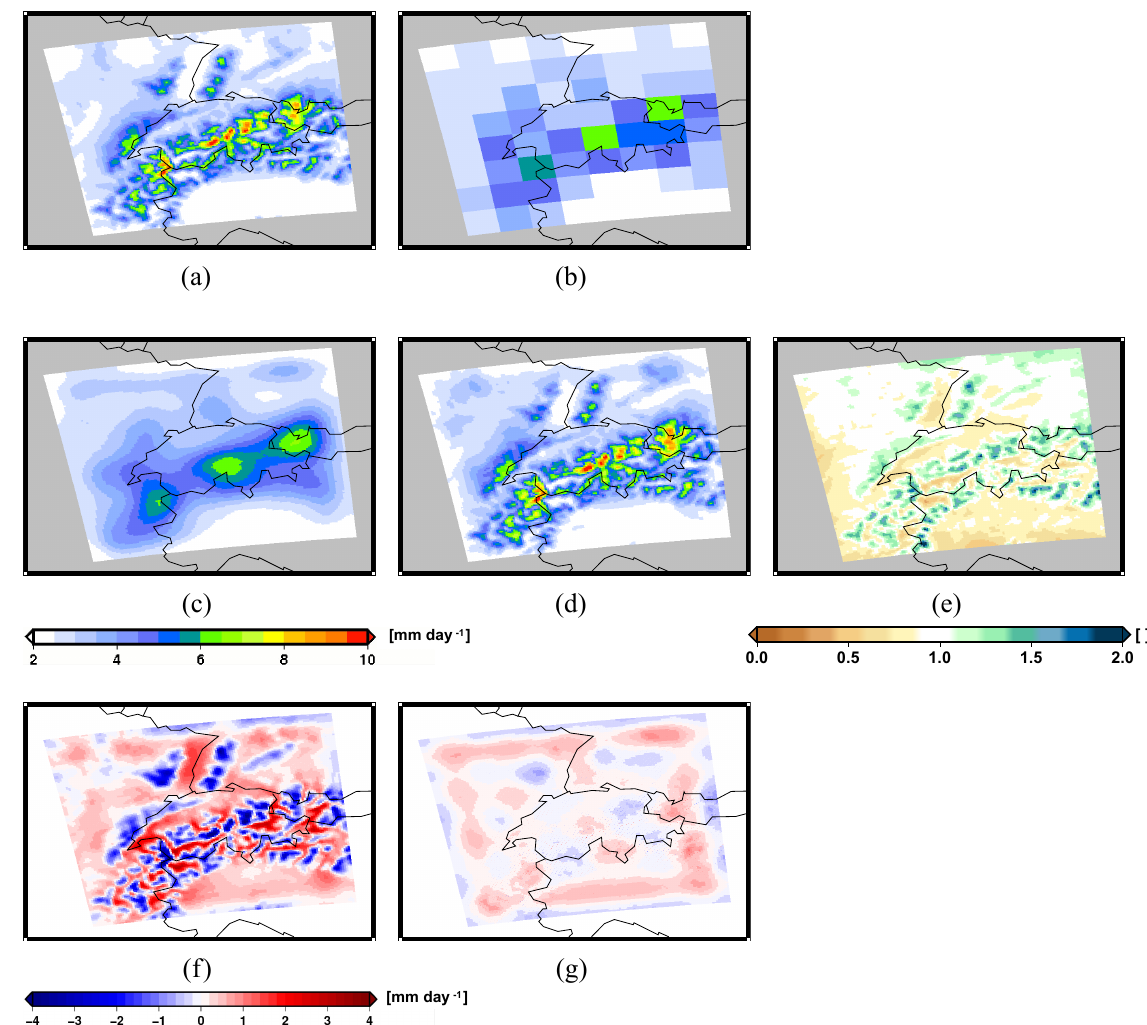
Figure 2. The “perfect-model” experiment. Average daily precipitation climatology (1980–2008) derived from (a) high-resolution WRF daily fields at 4km, here considered to be the“truth”; (b) WRF daily fields aggregated at 64km, i.e., the fields, P(X , Y , t) , to be downscaled; (c) P(X , Y , t) downscaled at 4km using the standard RainFARM method; (d) P(X , Y , t) downscaled at 4km using the modified RainFARM method; (e) an example of a map of weights obtained in this case for the month of June; (f, g) anomalies of the downscaled climatologies in (c) and (d) with respect to the reference precipitation field (a)